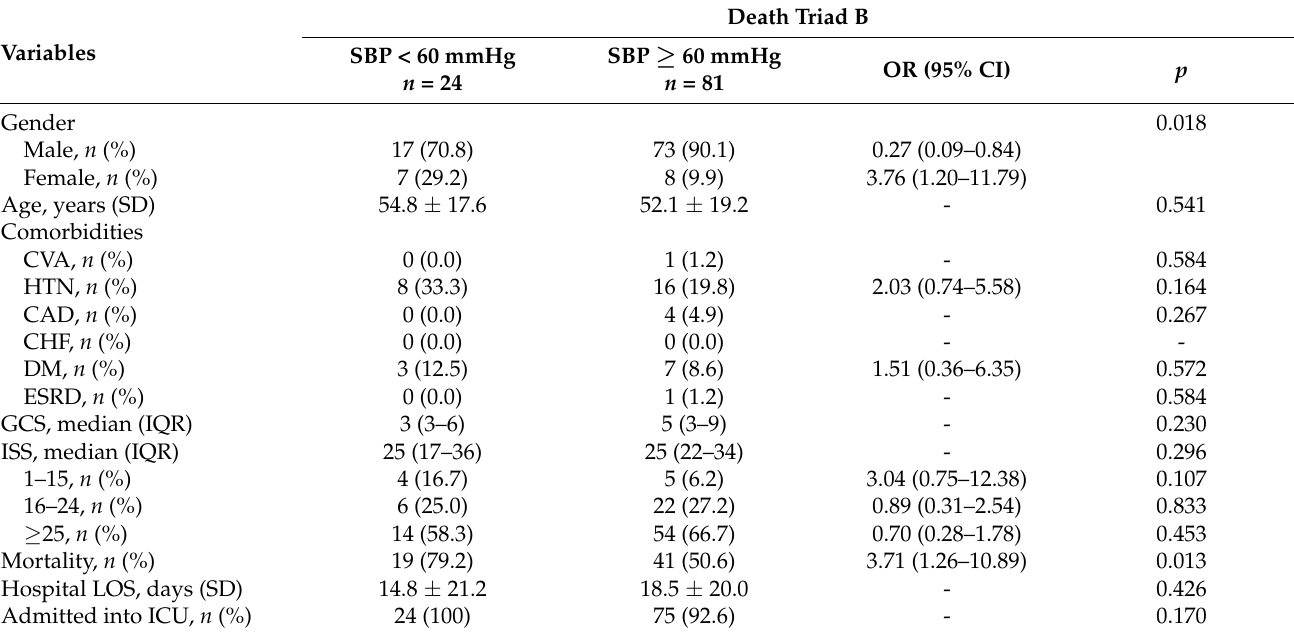
Table 3. The injury characteristics and outcome of trauma patients in death triad B with or without systolic blood pressure less than 60